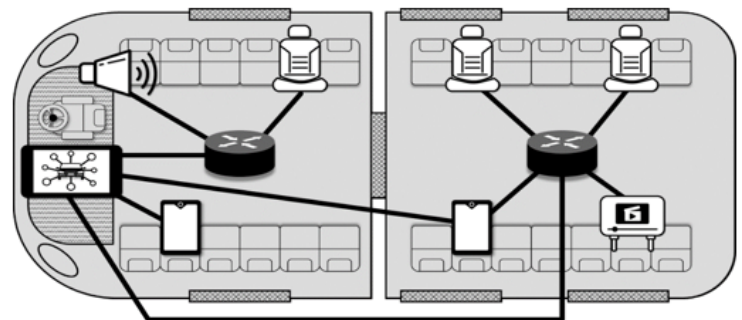
Figure 4. Example of A-IVI configuration in public transportation .